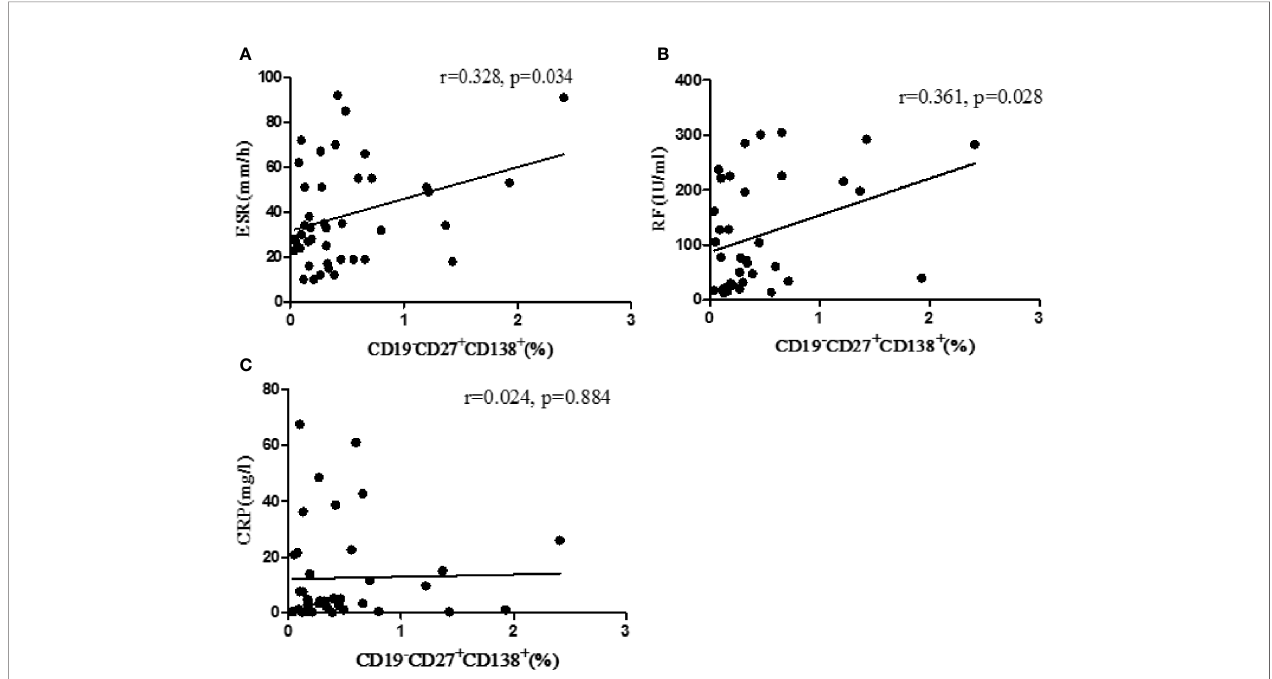
FIGURE 1 | Correlation between the percentage of CD19 − CD27 + CD138 + B cells and laboratory parameters. (A) The correlation between percentage of B cells with ESR. (B) The correlation between the percentage of B cells with RF. (C) The correlation between the percentage of B cells with CRP. r, correlation coef fi cient; p, signi fi cant level. p < 0.05 indicates statistical signi fi